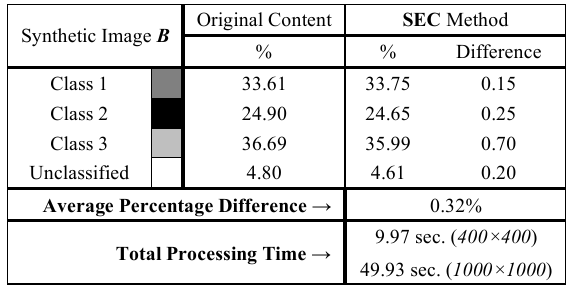
Table 3. Comparative table of the class percentages obtained by the SEC method for the synthetic image B Synthetic Image C